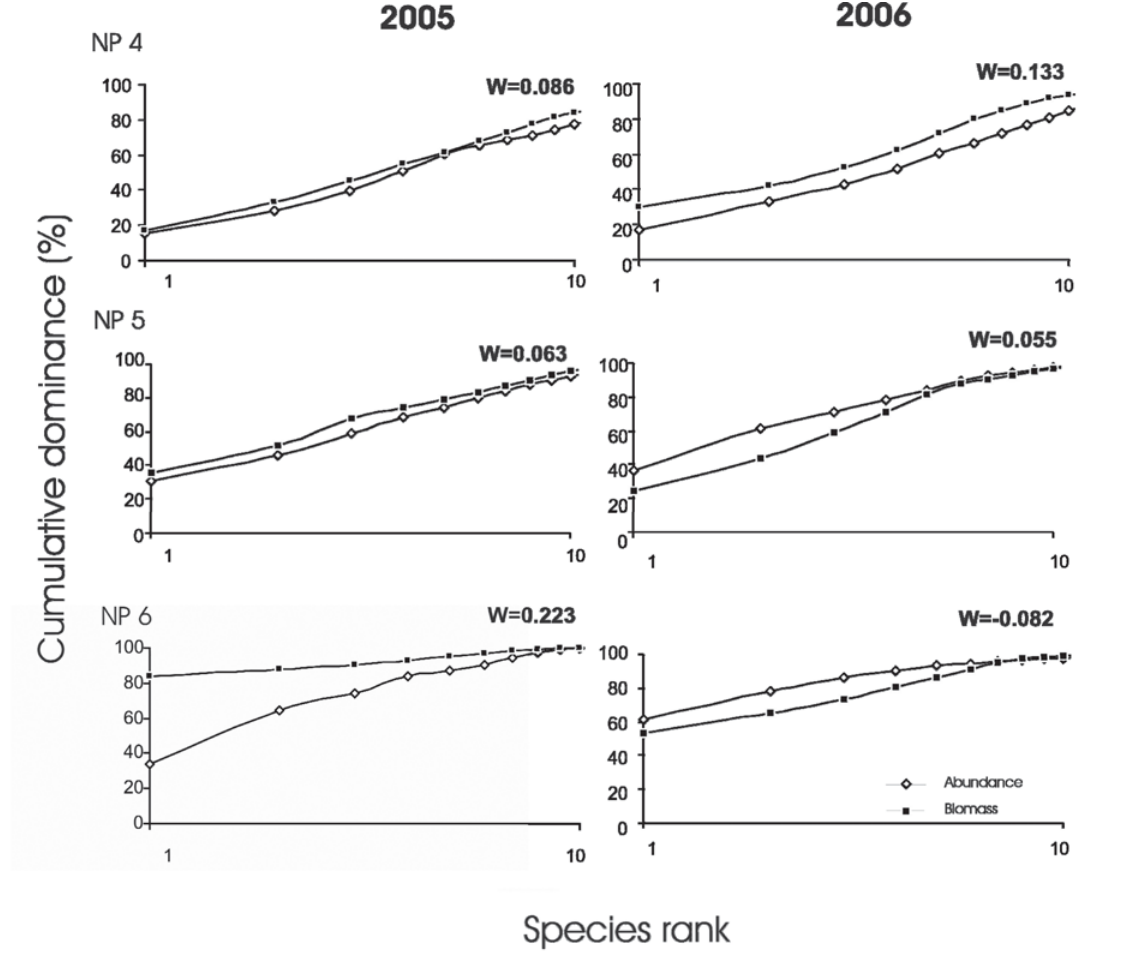
Fig. 6. ABC curves per year of fish assemblages from stream stretches located in impacted areas. NP4 = Bandeira; NP5 = Pedreira; NP6 = Unnamed Stream 2. W = statistical value for each